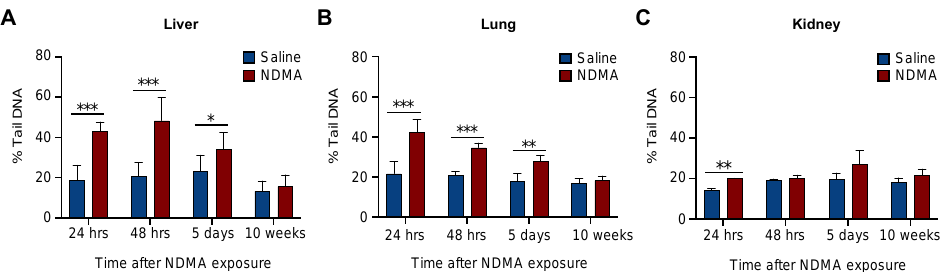
Figure 5. Repair of NDMA-induced strand breaks over time in the liver, lung and kidney. Mice were either sham treated or exposed to 10 mg/kg of NDMA, and liver, lungs and kidneys were collected 24 hours, 48 hours, 5 days and 10 weeks after injection and tissues analyzed with the alkaline CometChip. Bar graphs represents quantification of DNA strand breaks at all the time points in the ( A ) liver ( B ) lung and ( C ) kidney. Percent tail in DNA is represented as the mean of three mice ± SD. Unpaired Student’s t -test, * p < 0.01, ** p < 0.01, *** p < 0.001.